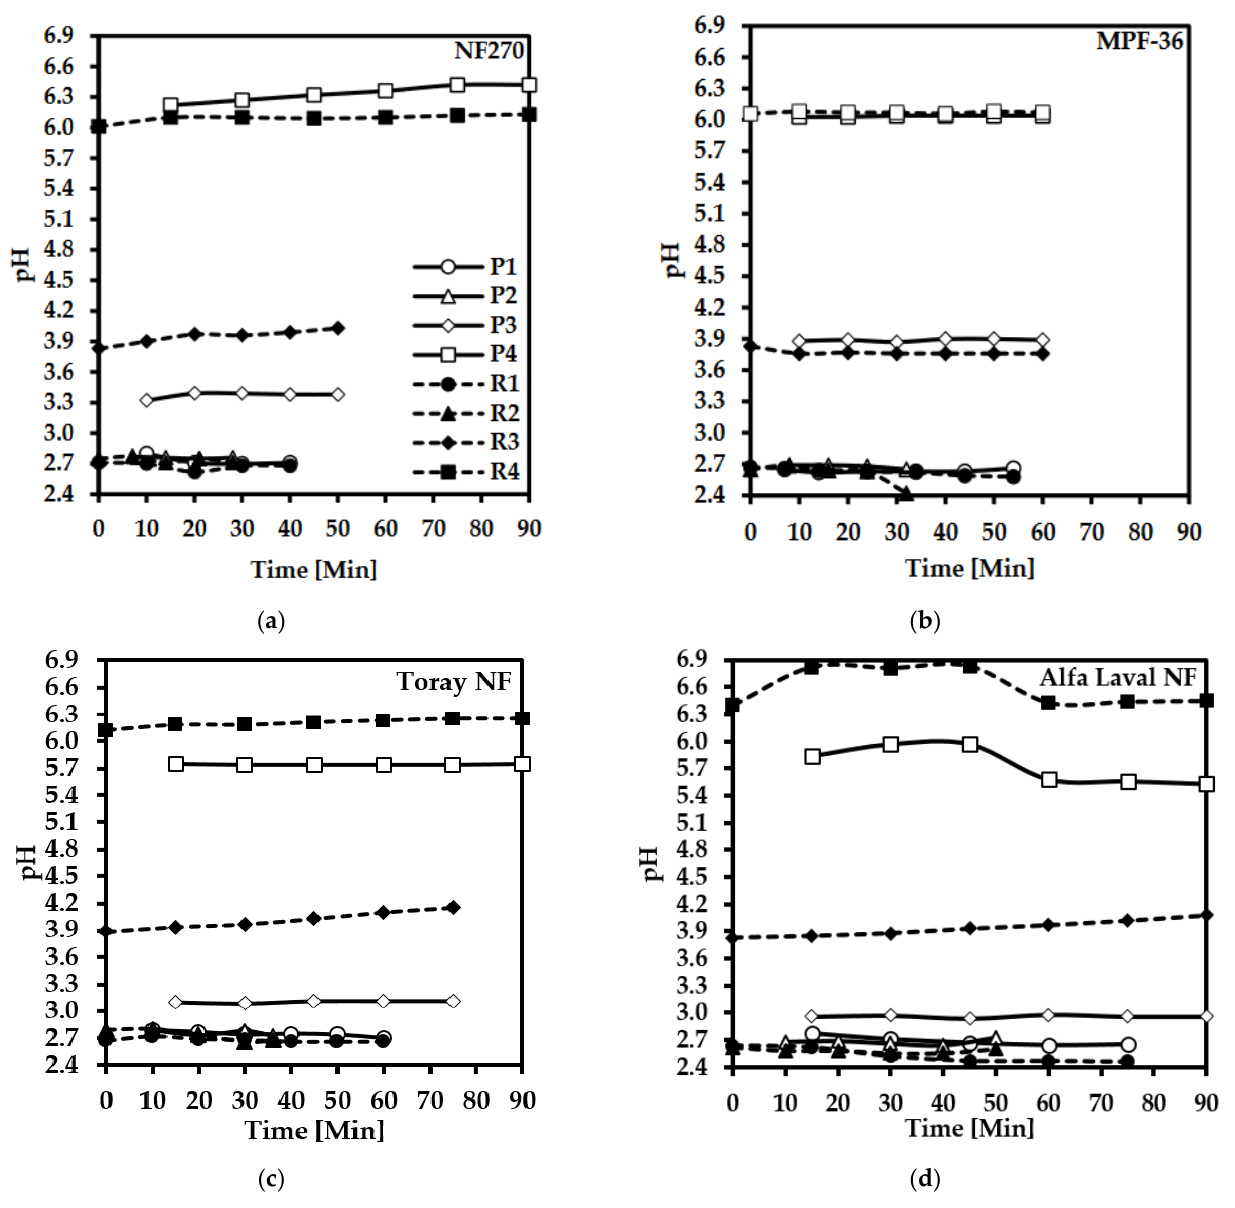
Figure 5. pH variation of the binary solution of lactic acid over time using different membranes: ( a ) NF270, ( b ) SelRO ® MPF-36, ( c ) Toray NF, and ( d ) Alfa Laval NF. P is the permeate, R is the retentate, and the numbers indicate the experiments listed in Table 3.